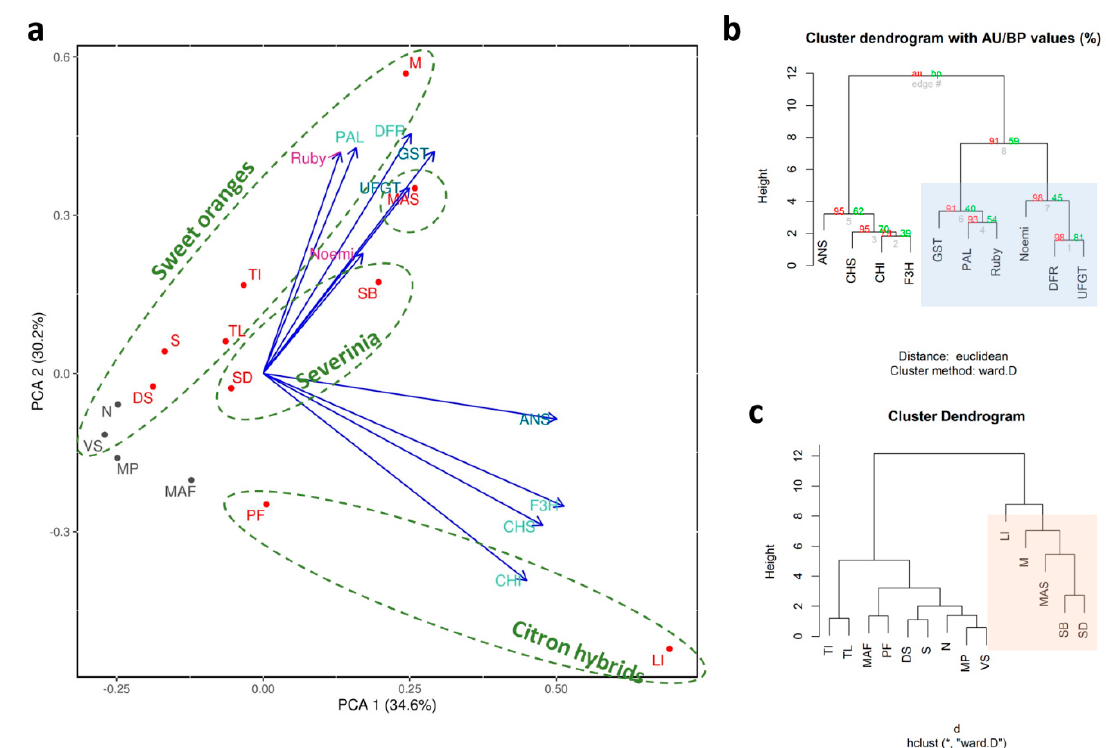
Figure 8. Statistical analyses carried out on accessions selected for their rind pigmentation. ( a ) Principal component analysis, cluster dendrogram based on the distribution of expression data focused ( b ) on genes where AU refers to Approximately Unbiased p -value and BP is for Bootstrap Probability value; and ( c ) on accessions. Accessions are coded: M paniculata —MP, ‘Vaniglia